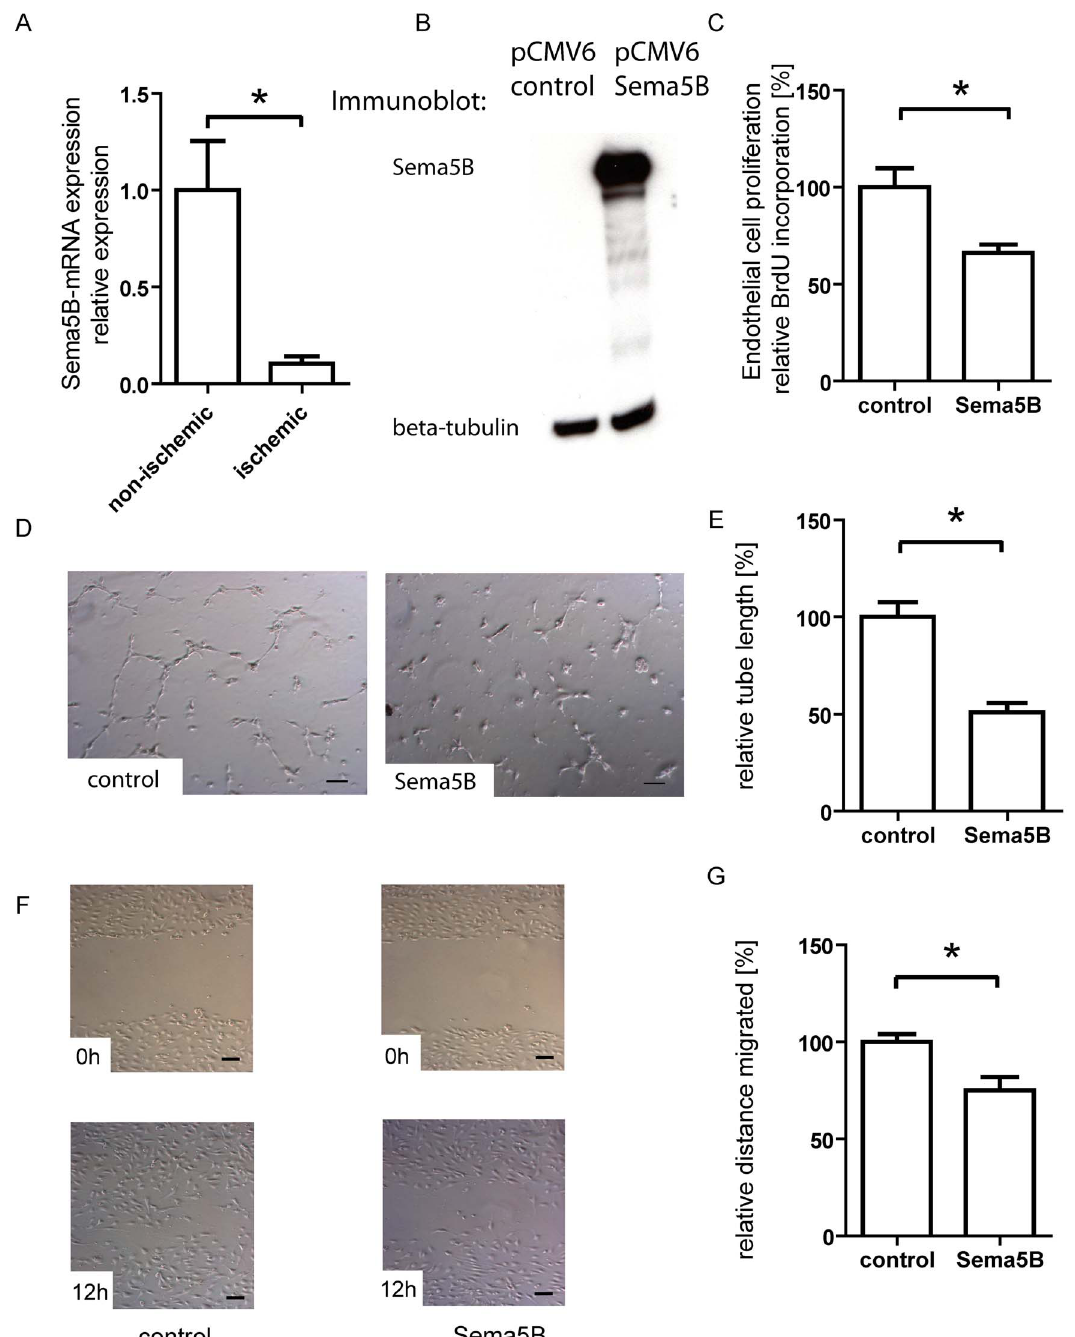
Figure 6. Semaphorin 5B is downregulated after induction of ischemia in vivo and inhibits endothelial cell proliferation, migration and tube formation. (A) In vivo, semaphoring is downregulated after induction of ischemia by femoral artery ligation in mice. (B) Transfection with a semaphorin 5B coding plasmid resulted in a strong overexpression of this cytokine in endothelial cells. In functional cell culture assays, semaphorin 5B overexpression mimicked the effects of FoxP1 knockdown and impaired angiogenic functions of endothelial cells. Specifically, semaphorin 5B overexpression attenuated endothelial cell proliferation as measured by BrdU-incorporation (C) and endothelial tube formation on the planar matrigel assay (D), resulting in a shorter total tube length (E). Migration in the wound healing assay was also impaired (F&G). (*=p , 0.05, Scale bars: 100 m m).